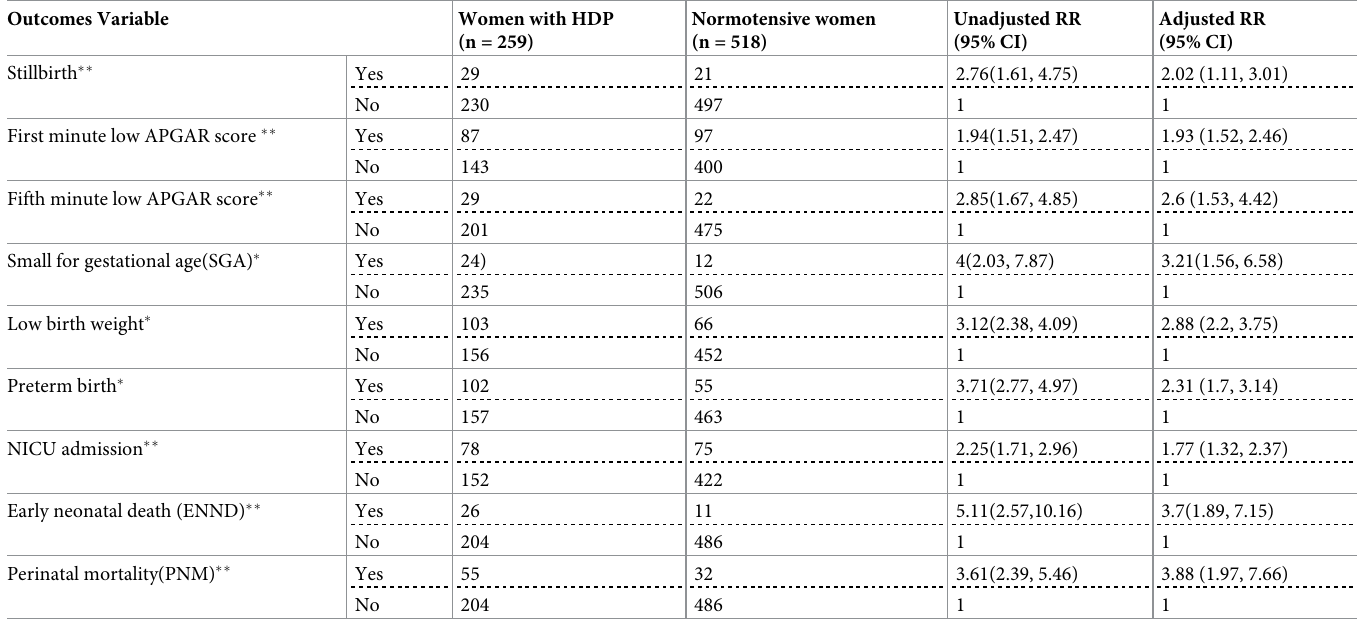
� RR- Relative Risk, were adjusted for maternal age, residence place, marital status, sex of the newborn, gravidity, history of anemia, ANC follow up, malaria infection, ante-partum hemorrhage, VDRL test, platelet count, maternal outcome and maternal HIV status. �� RR- relative risk were adjusted for all variable with � and additional for mode of delivery, fetal mal-presentation at birth, onset of labour and 1 represent control group.